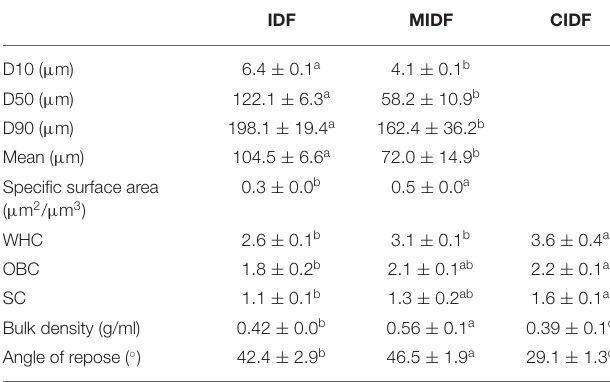
incubated at 37 ◦ C. The solution was collected and then mixed